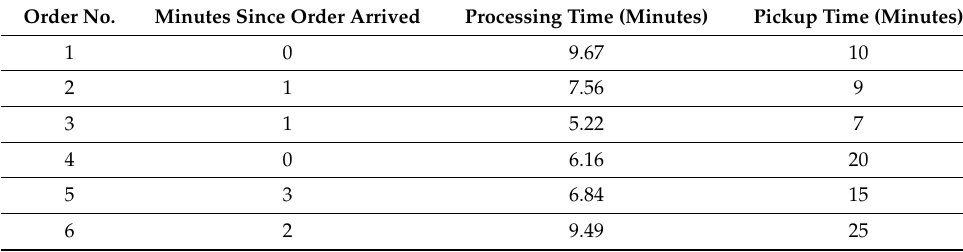
Table 3. The processing and pickup times of the set of orders.